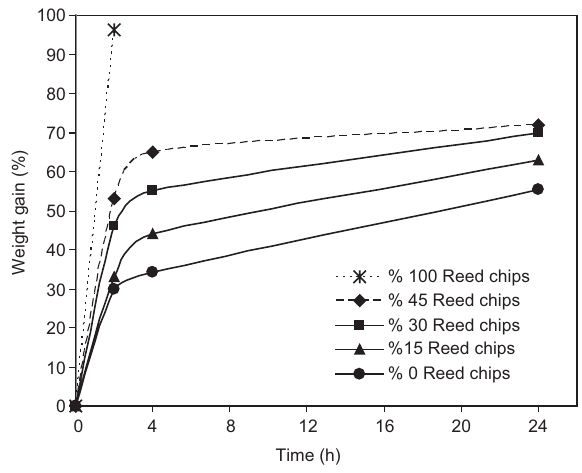
Figure 7 Reed chips increased the water